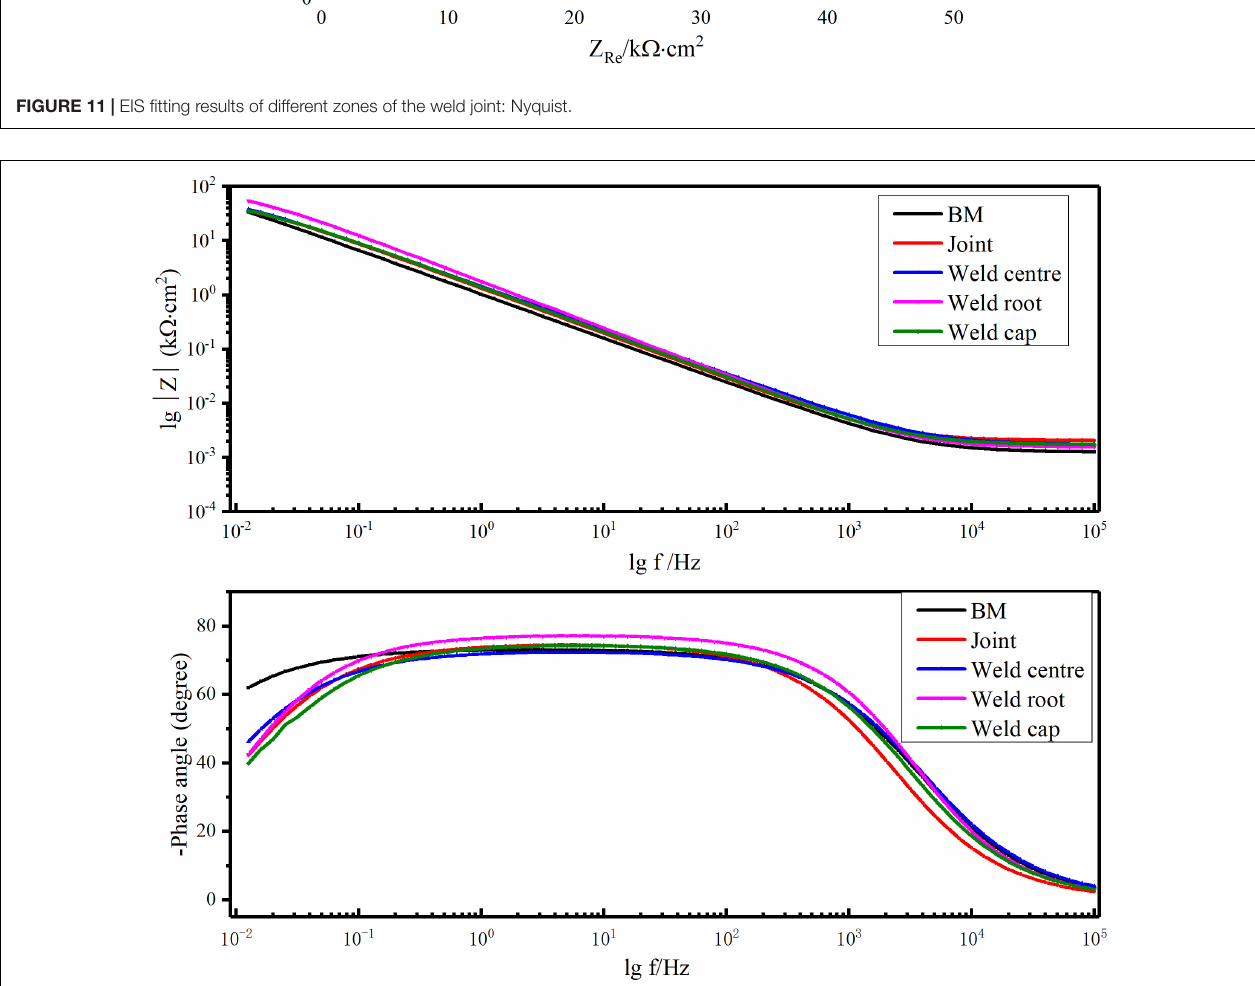
FIGURE 12 | EIS fitting results of different zones of the weld joint: Bode.